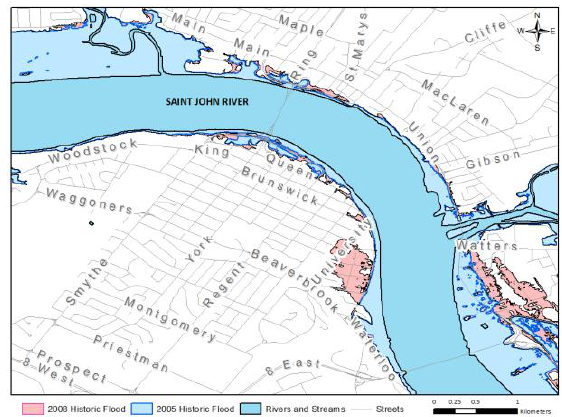
Figure 7. Two historic flood events, Fredericton,